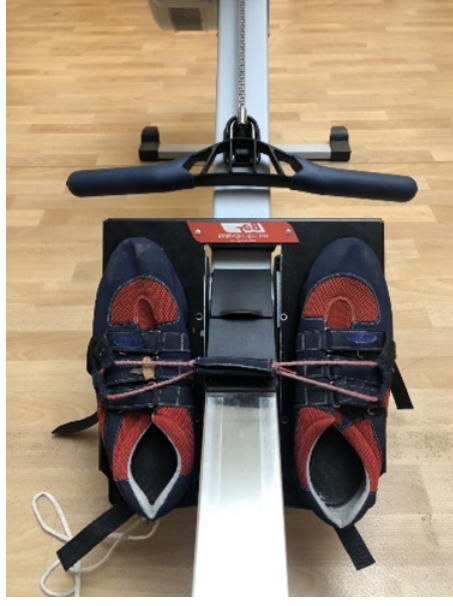
Figure 4. BAT Logic plate inserted onto a Concept2 Ergometer.